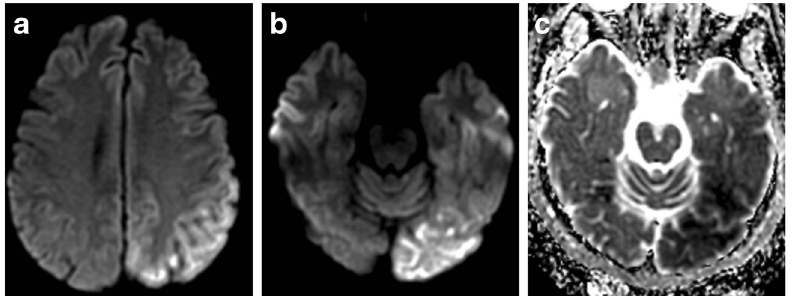
Fig. 6 Status epilepticus. Forty-eight-year-old woman with seizures and altered mental status. DWI ( a , b ) demonstrates a predominantly increased signal with left parietal, occipital, and posterior temporal cortex. ADC ( c ) demonstrates a corresponding low signal consistent with reduced